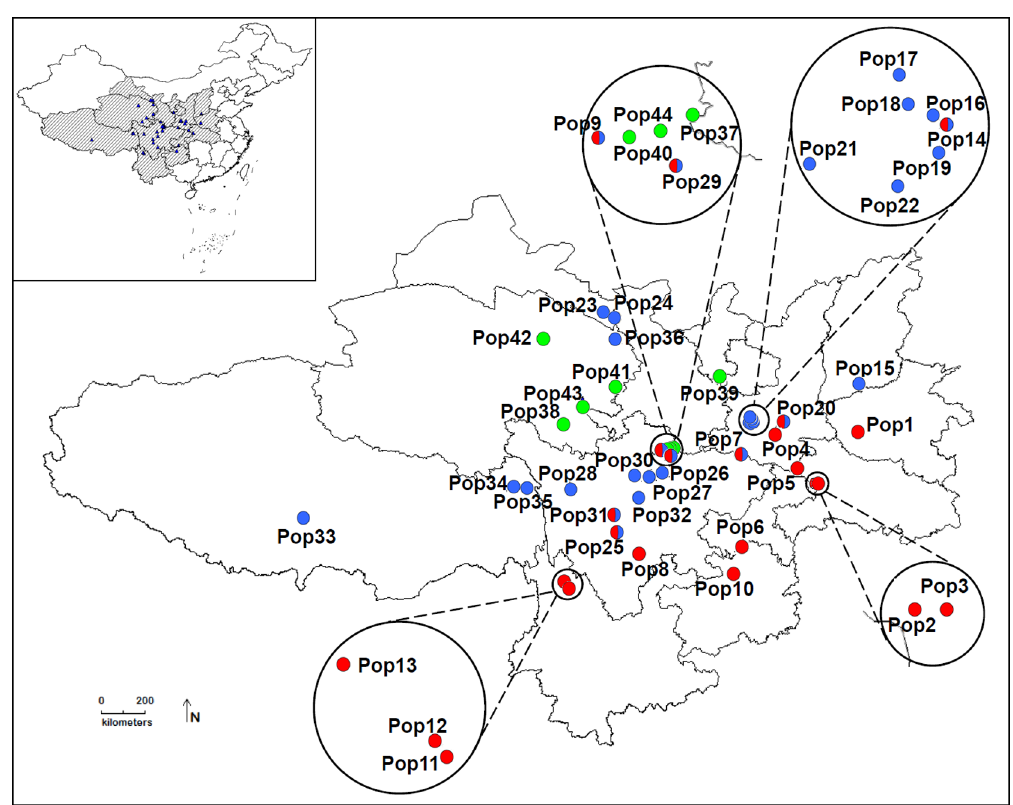
Figure 1. Geographic distribution of the 44 studied populations of Rheumpalmatum complex.